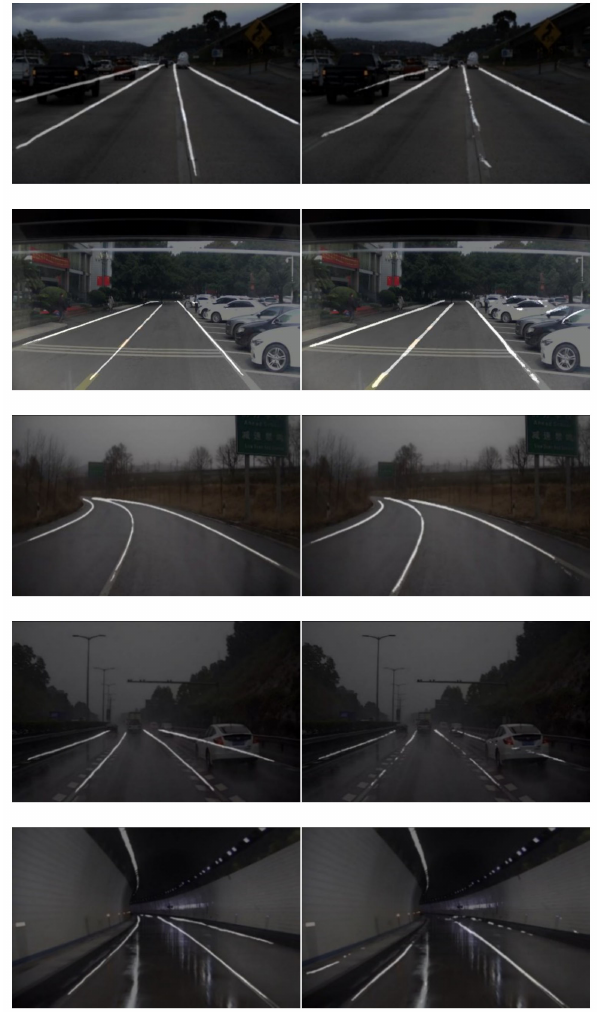
Figure 13. Comparison between our method and